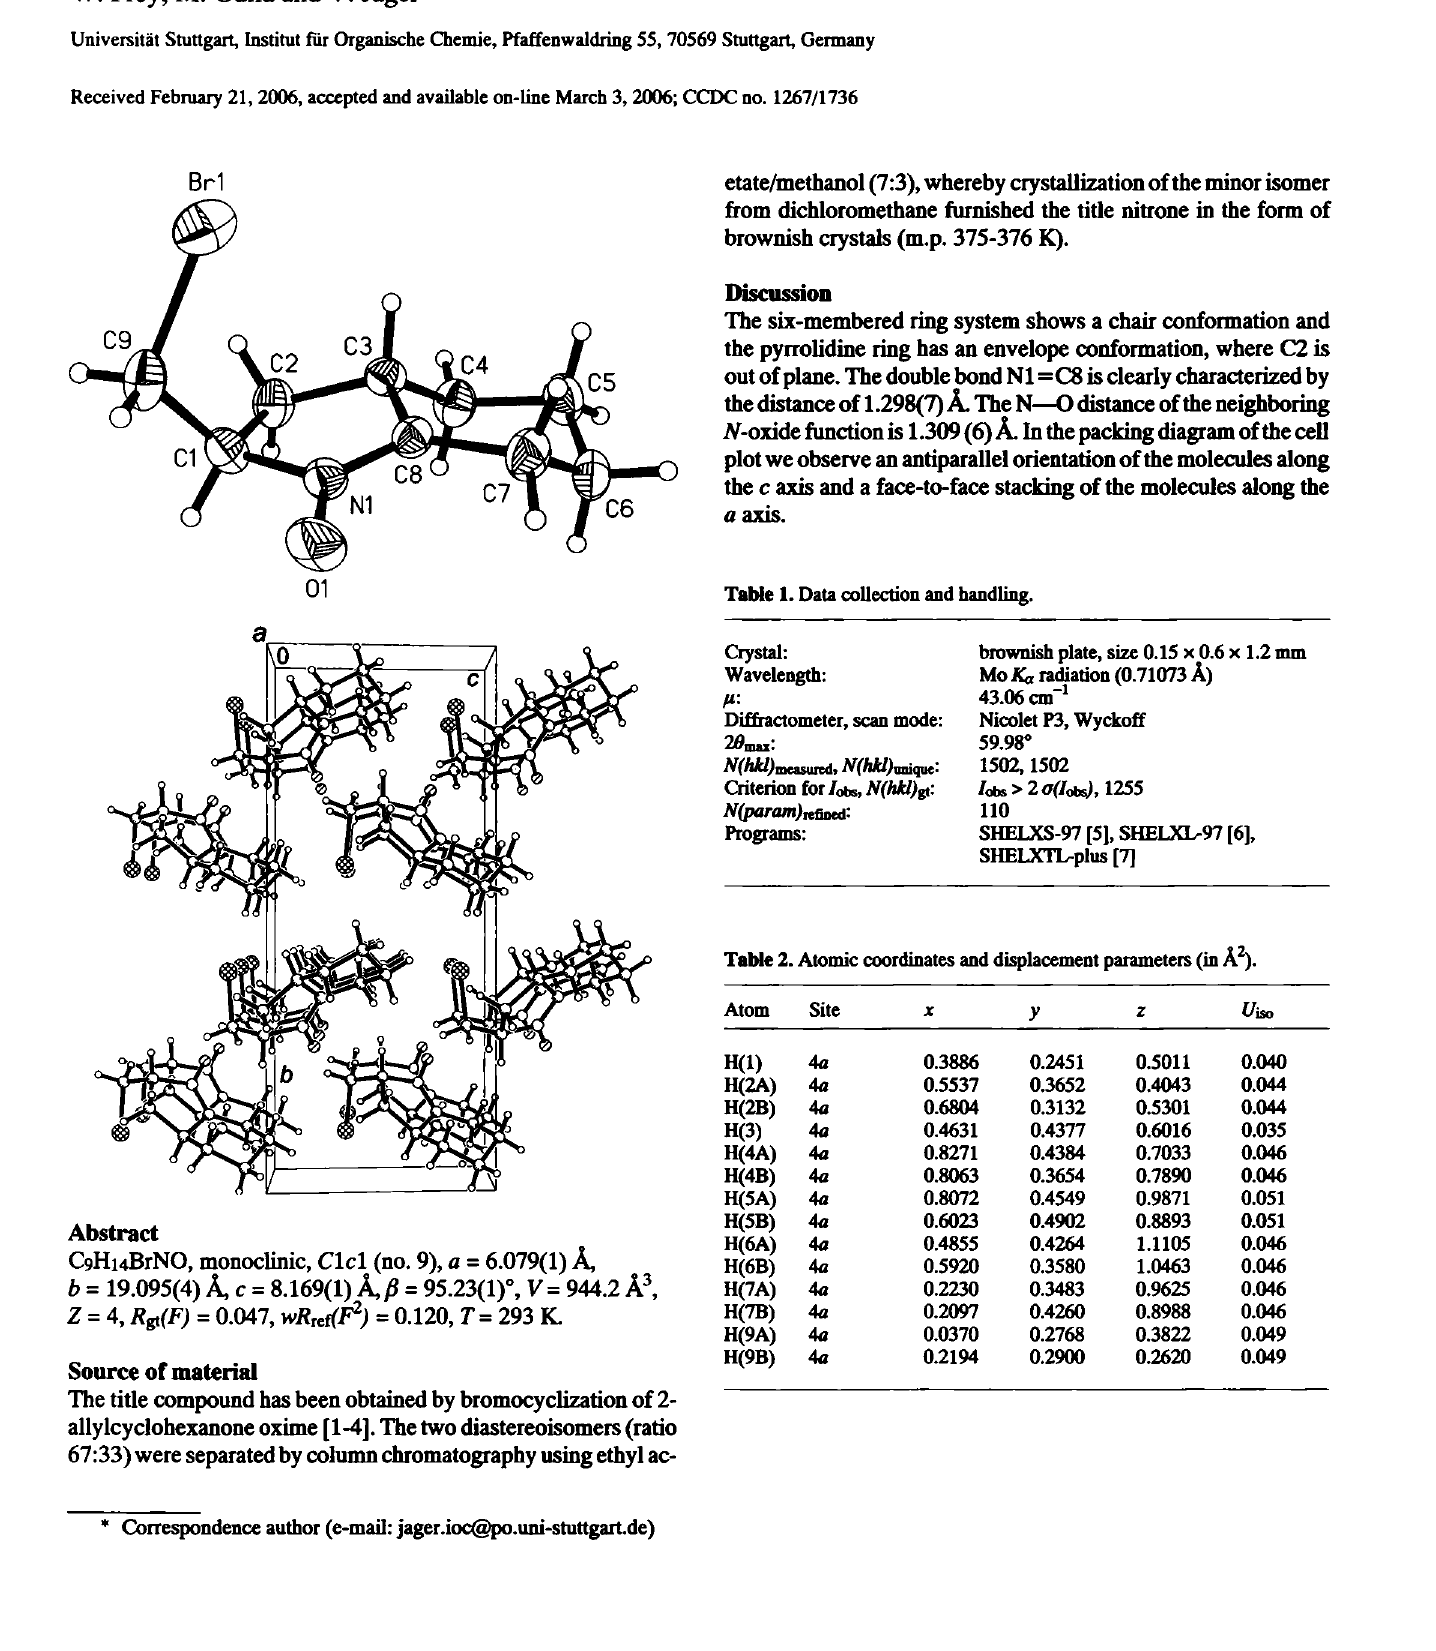
Table 1. Data collection and handling.